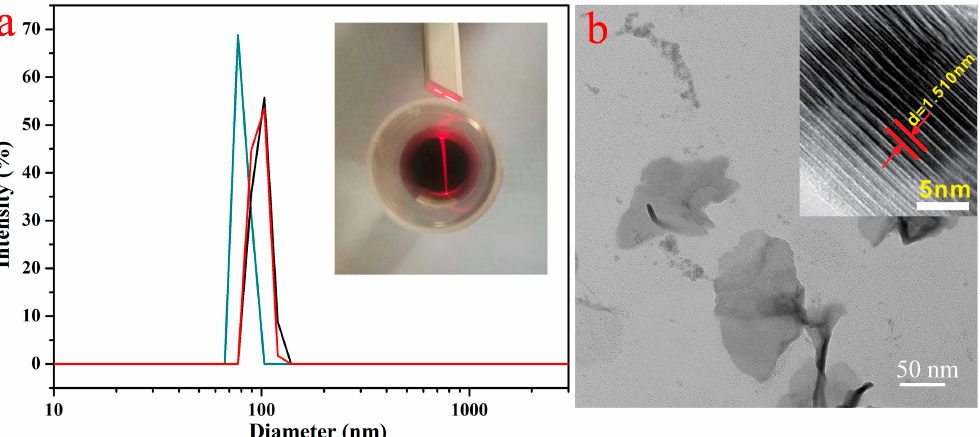
Figure 1. Size distribution ( a ) and typical transmission electron microscopy (TEM) image ( b ) of the obtained MXene-SO3H particles; the inset images denoted MXene-SO3H colloidal solution with Tyndall scattering effect and the high-resolution TEM image of MXene-SO3H.